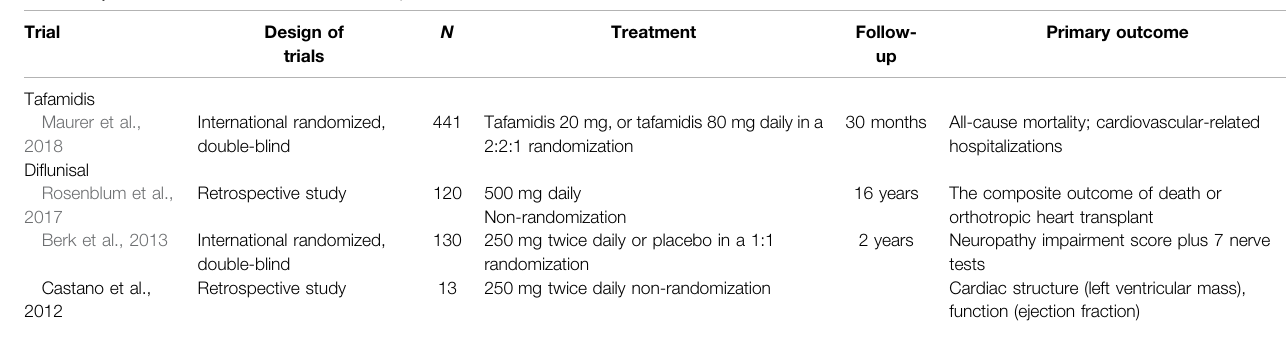
TABLE 1 | Clinical trials of structural stabilizers in patients with ATTR-CM. N Treatment Follow- Trial Design of trials